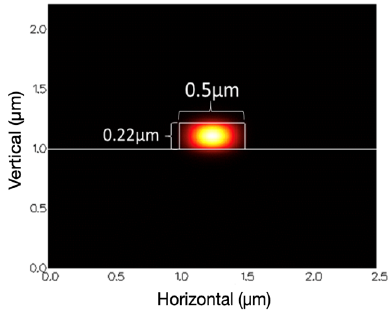
Table 1. Silicon wire group index variation under various cladding refractive indices.